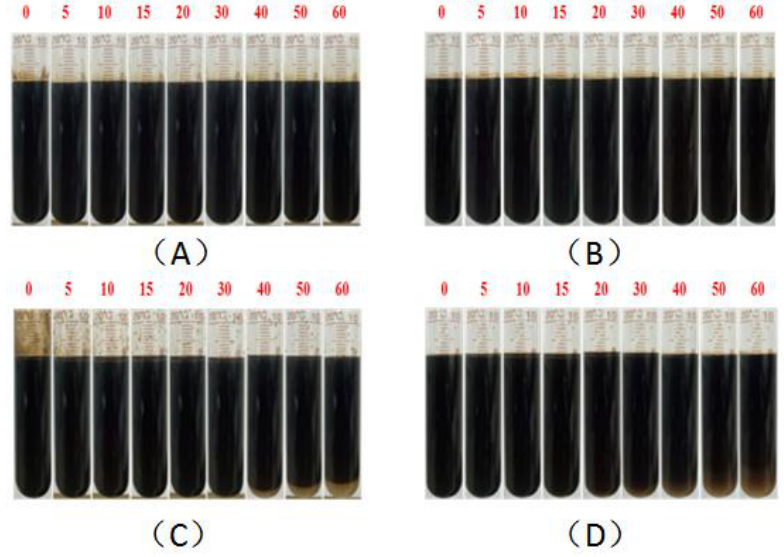
Figure 11. Evaluation of emulsion properties of binary systems by the bottle test: 0.3% KPS + 1500 ppm 1200 W HPAM ( A ), 0.3% KPS + 1500 ppm 1100 W HMPAM ( B ), 0.3% (BSB/Z1) + 1500 ppm 1200 W HPAM ( C ), 0.3% (BSB/Z1) + 1500 ppm 1100 W HMPAM ( D ).